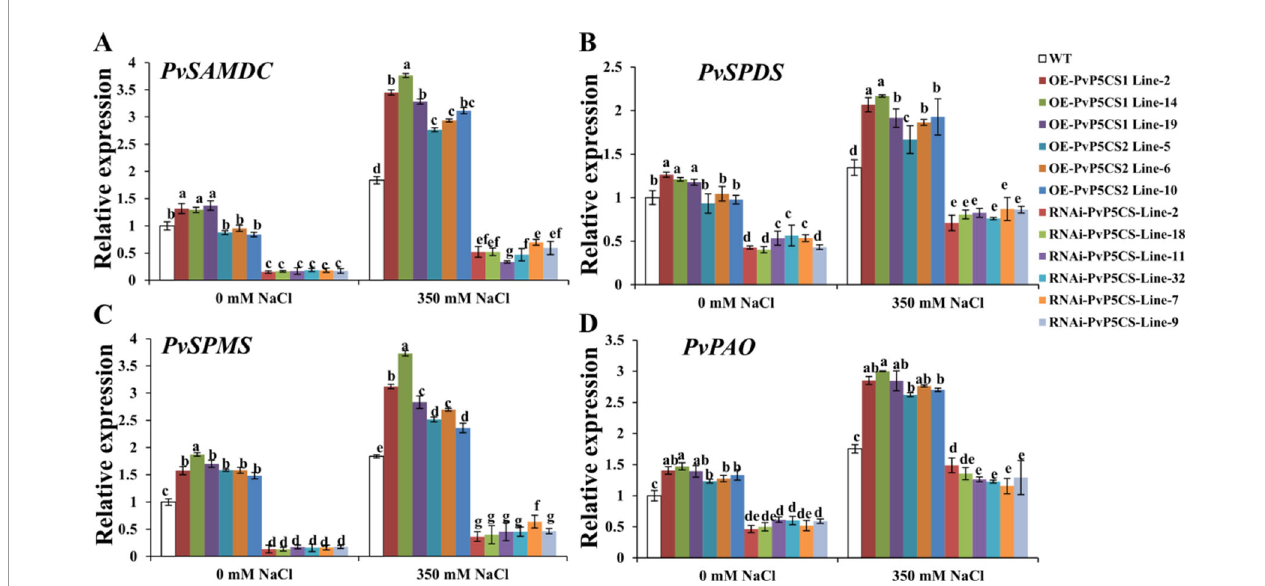
FIGURE 7 | Transcript levels of the genes involved in polyamine synthesis (A – C) and catabolism (D) in PvP5CS OE and RNAi transgenic plants under control and salt stress conditions. Switchgrass UBQ1 was used as the reference for normalization. Data are mean values of three biological repeat, and signi fi cance of treatments was tested at the P < 0.05 level (one way ANOVA, Dunnett's test).